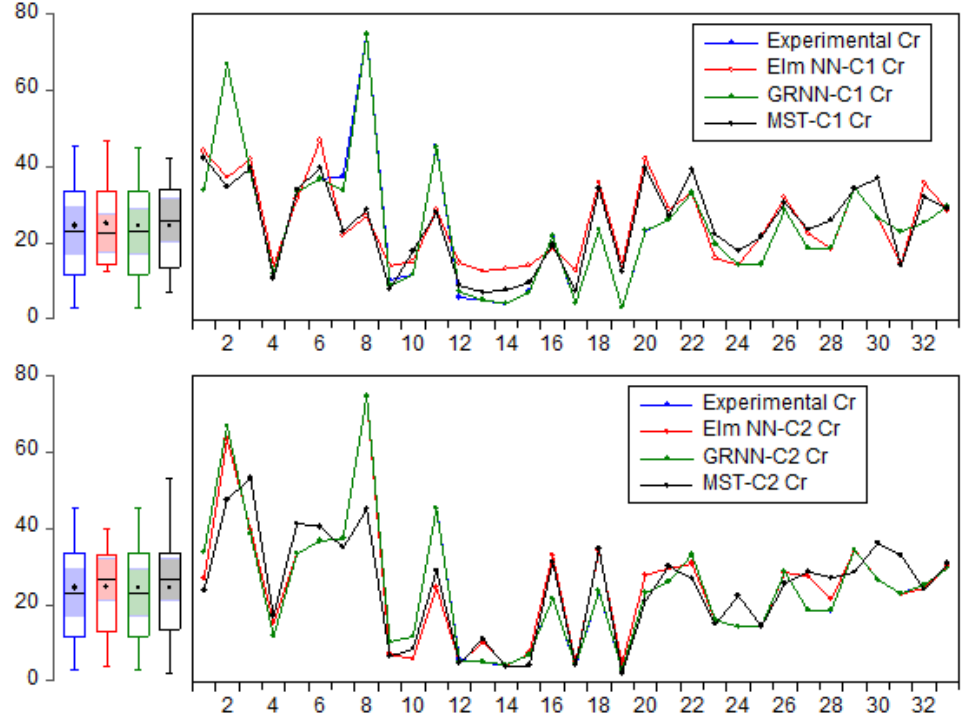
Figure 10. Trend of estimation of the GRNN, Elm NN, and MST models against the experimental Cr concentration (mg/kg).